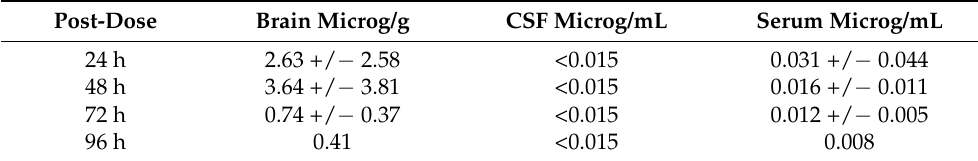
Table 3. Azithromycin level after a single 500 mg oral dose. References in text. Post-Dose Brain